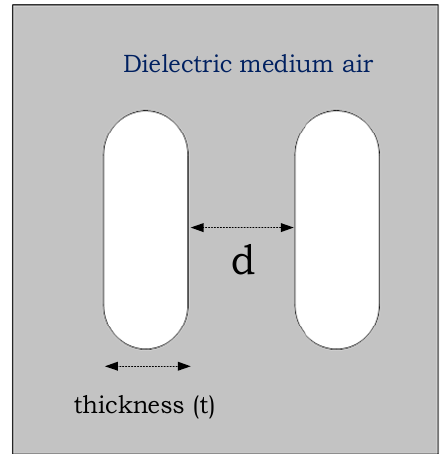
Figure 5. Basic model of two electrode sparkgap switch.